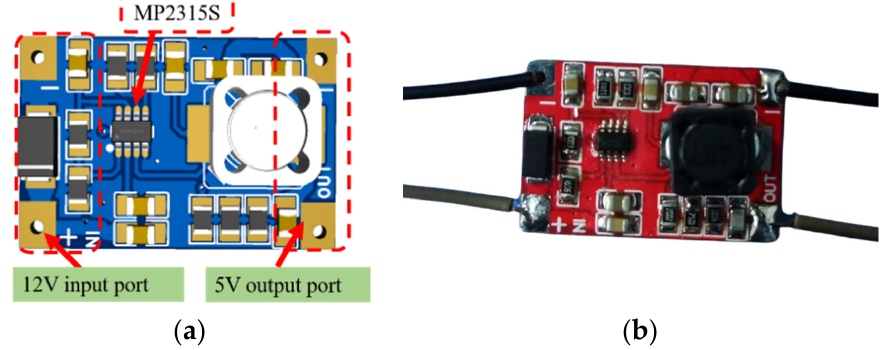
Figure 18. ( a ) DC ‐ DC controller, PCB layout. ( b ) DC ‐ DC controller, physical picture. Figure 18. ( a ) DC-DC controller, PCB layout. ( b ) DC-DC controller, physical picture.